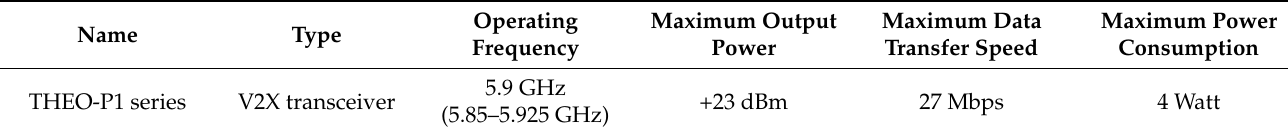
Table 2. Technical characteristics of the DSRC